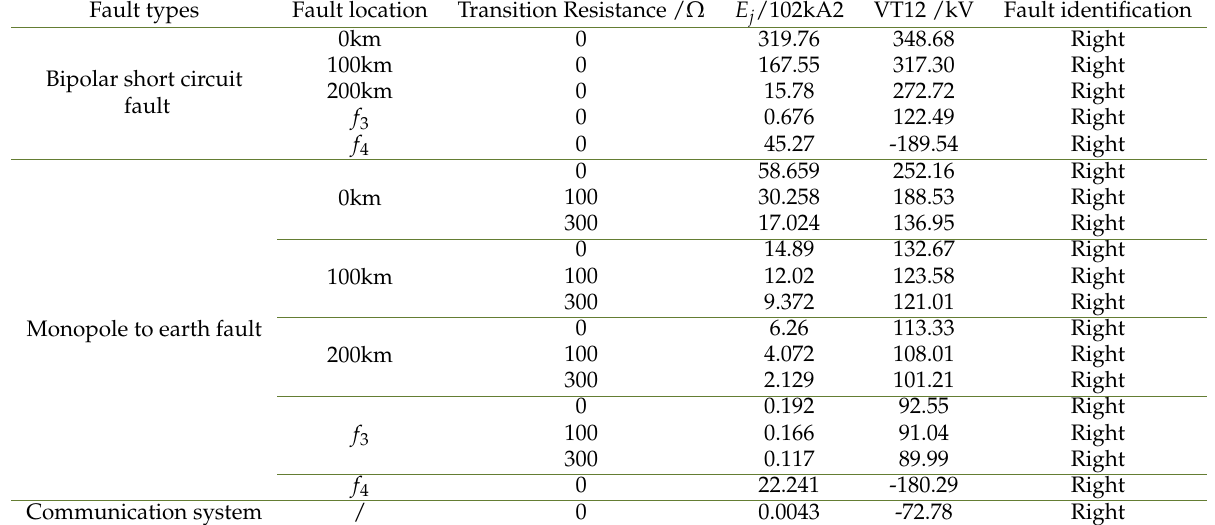
Table 3. Action property of the proposed protection strategy in the MMC-based DC